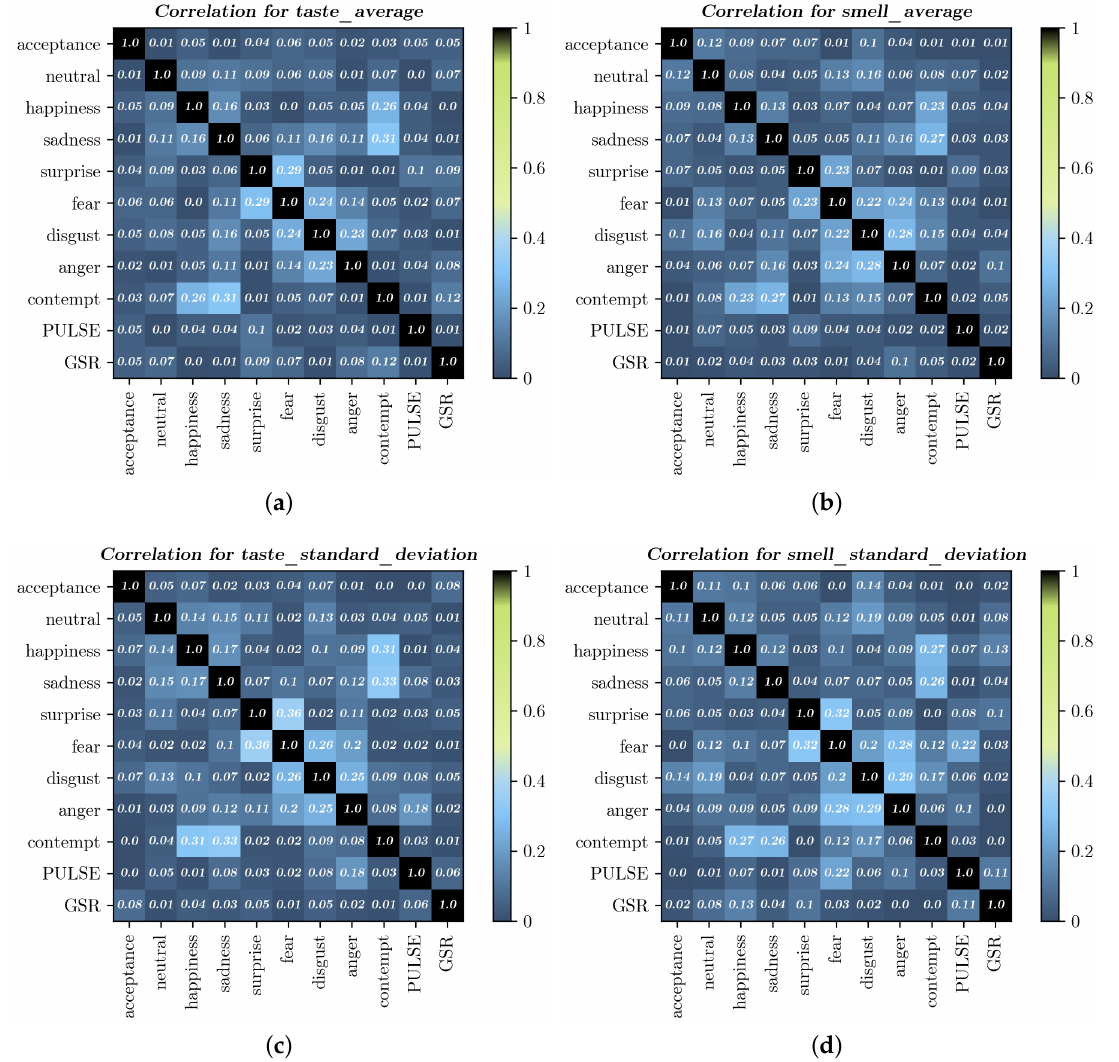
Figure 14. Correlation matrix of facial emotion recognition (FER), sensor responses, and consumer acceptance: ( a , c ) display the correlation matrices of taste experiments, while ( b , d ) show the correlation matrices of smell experiments. Cells contain correlations between column and row